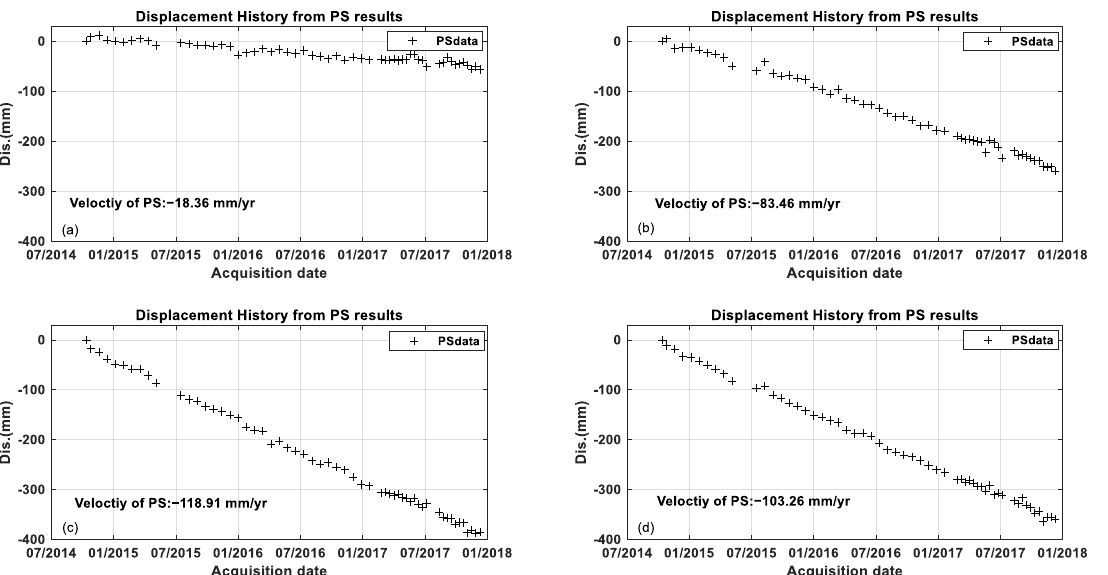
Figure 8. The average subsidence velocity comparison along the planned railway line. There were four points (3, 5, 7, and 11) along the planned high-speed railway that were selected; their displacement history from PS results is illustrated in Figure 9. Their displace- ment is plotted vertically. Figure 9a – d shows the displacement history of these four points. The average displacement velocity of these four points are − 18.36 mm/yr, − 83.46 mm/yr, − 118.91 mm/yr, and − 103.26 mm/yr, respectively. The time series of these points shows a strong linear displacement trend of these points from the MT-InSAR results.